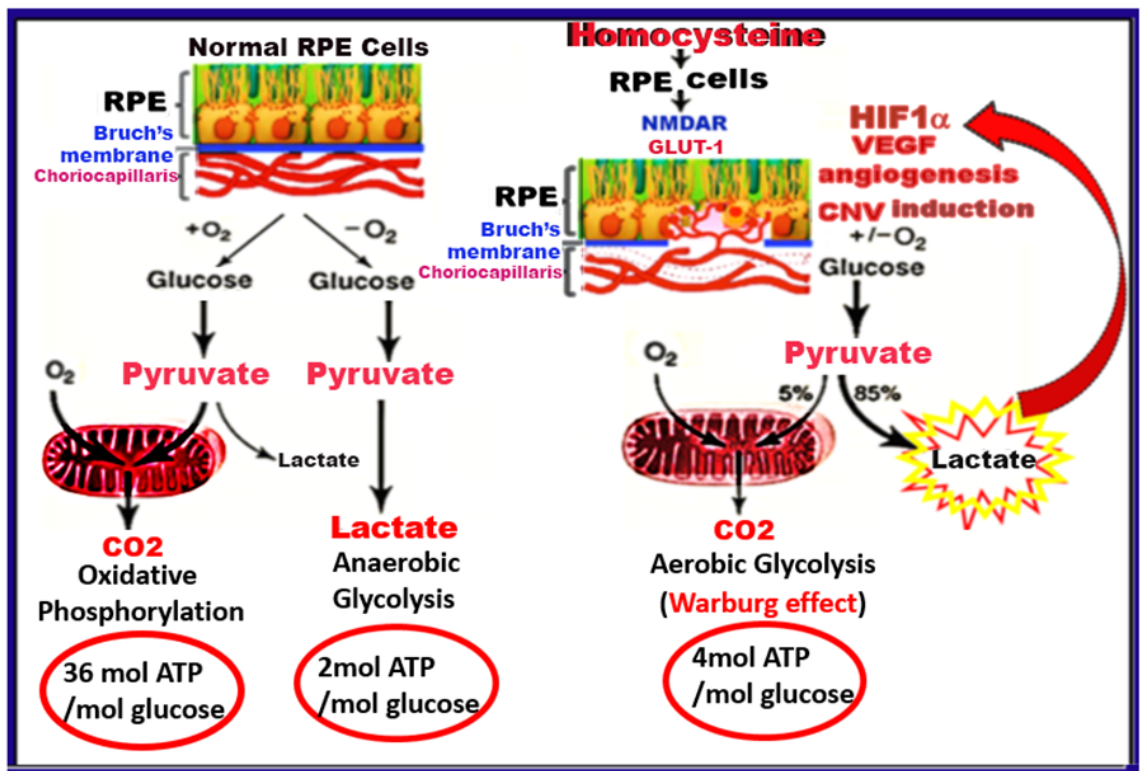
Figure 1. The schematic diagram for the research hypothesis. Schematic representation of the study’s hypothesis of HHcy involvement in glycolysis, RPE dysfunction, and CNV induction via up-regulation of GLUT-1 in RPE cells, inducing a Warburg-like effect in which cells predominantly produce energy by a high rate of glycolysis, rather than by a comparatively low rate of glycolysis followed by oxidation of pyruvate in mitochondria.